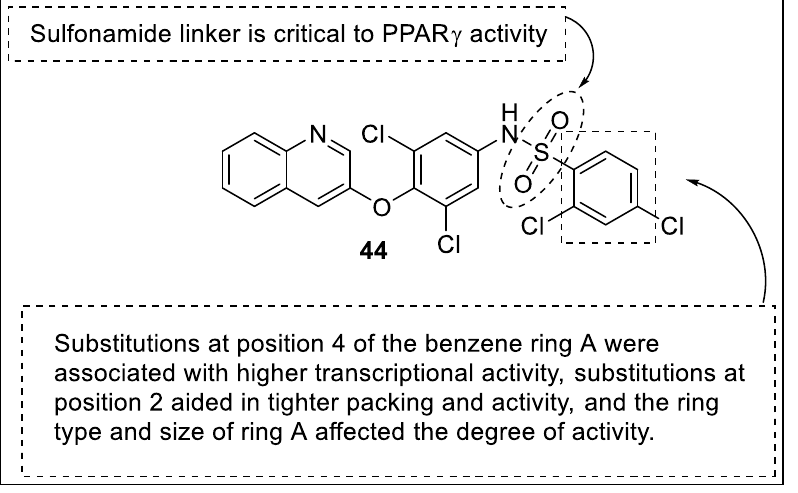
Figure 48. Structural activity relationship of INT131 hybrids ( 44 ) as potent PPAR ligands .